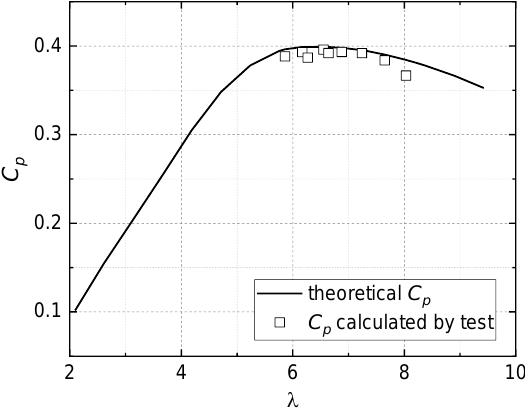
Figure 4. C p calculated by test versus theoretical value.